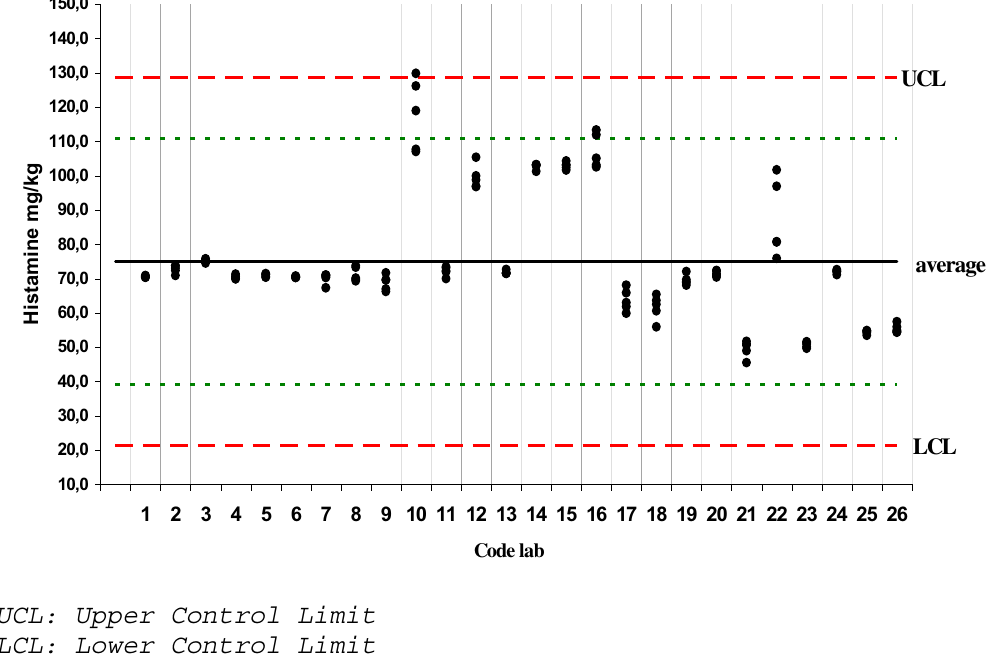
Fig. 4. (Color online) Histamine (mg/kg), in the level 2 matrix obtained by the 26 participating laboratories.